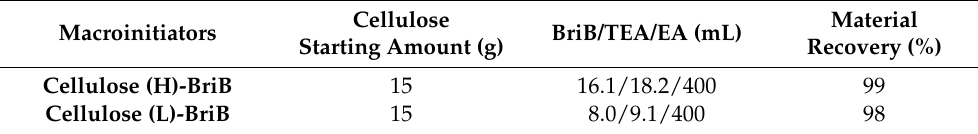
Table 1. Cellulose-BriB macro(alkyl halides) prepared by esterification of MCC with 2-BriB in EA/TEA at room